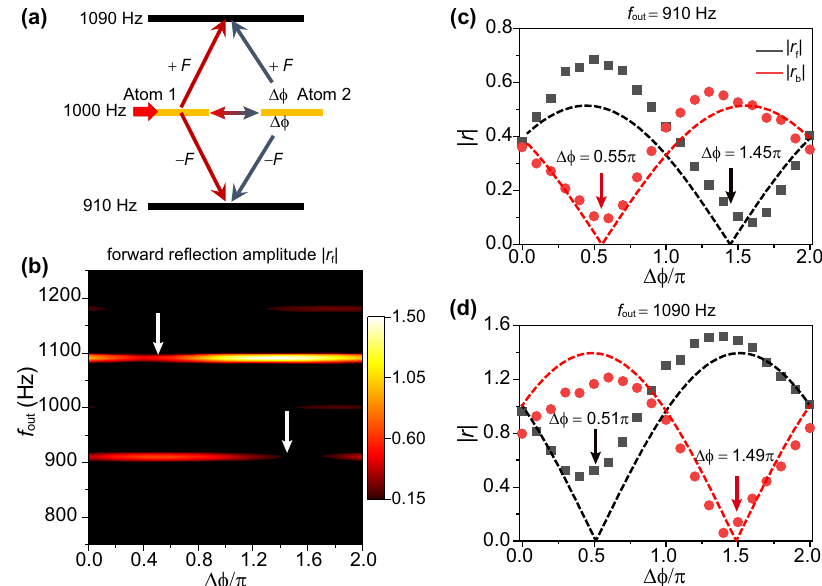
Fig. 3 Unidirectional ampli fi cation in a non-Hermitian space − time varying metamaterial. a The “ energy-level ” diagram for two time-varying meta-atoms with the same resonance frequency (yellow bars) and modulation frequency, and a modulation phase delay Δ ϕ is applied on atom 2. b The 2D map of the (cid:6) (cid:6) (cid:6) (cid:6) against the modulation phase delay Δ ϕ and the output frequency, where arrows indicate the destructive dip position calculated from the harmonic r f model. The forward and backward re fl ection amplitudes spectra with different interference conditions reveal the asymmetric scattering property for both m = − 1 ( c ) and m = 1 harmonics ( d ). Particularly, unidirectional ampli fi cation occurs around Δ ϕ ¼ 1 : 4 π for the harmonic with m = 1. Here symbols represent the experimental results, and dashed lines represent the numerical simulation results.